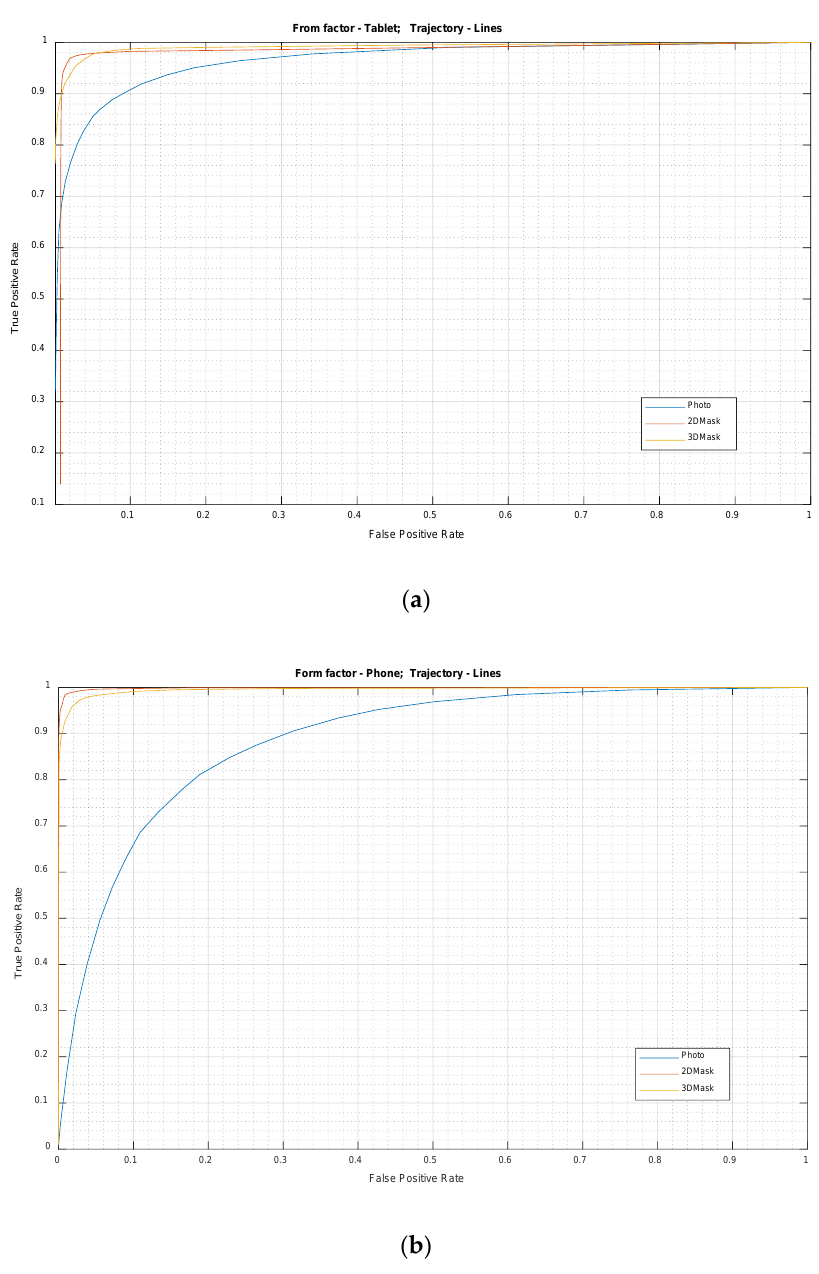
Figure 5. ROC curves for the photo, 2D mask and 3D mask. Stimulus trajectory: Lines . Form factors: ( a ) tablet format; and ( b ) phone format.